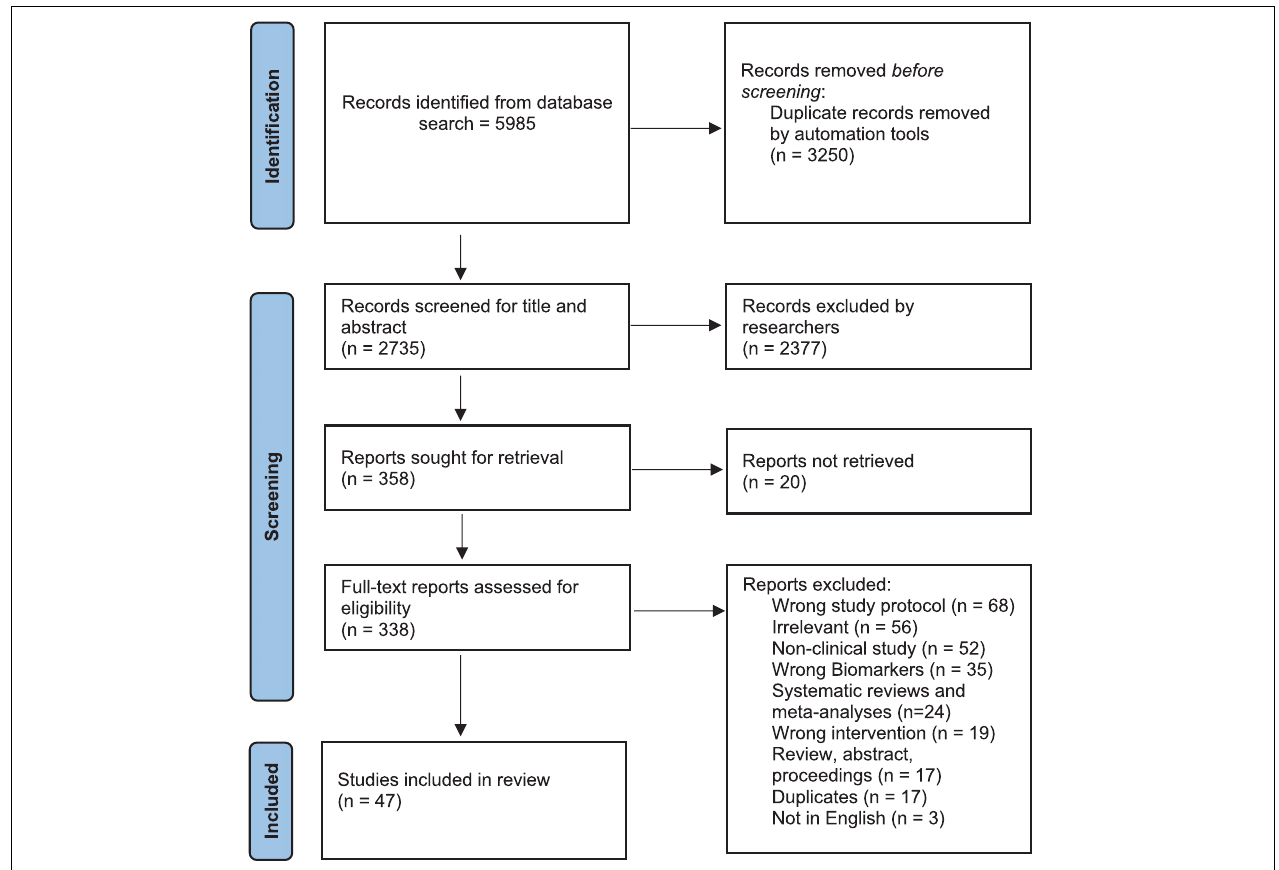
FIGURE 1 | Flowchart of search strategy, inclusion, and exclusion